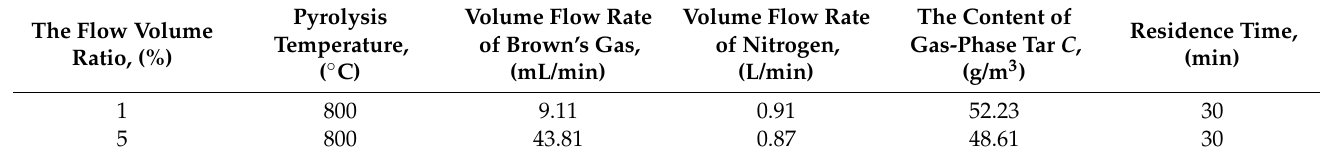
Table 4. Parameters required for